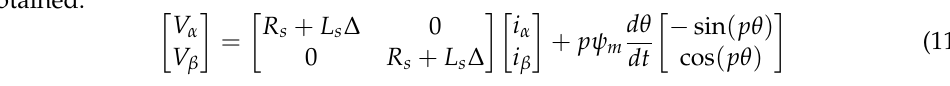
Figure 3. Circuit model of stepper motor ( a ) for d axis, ( b ) for q axis. By substituting (6) and (7) in (9) and (10), respectively, then the Equation (11) is